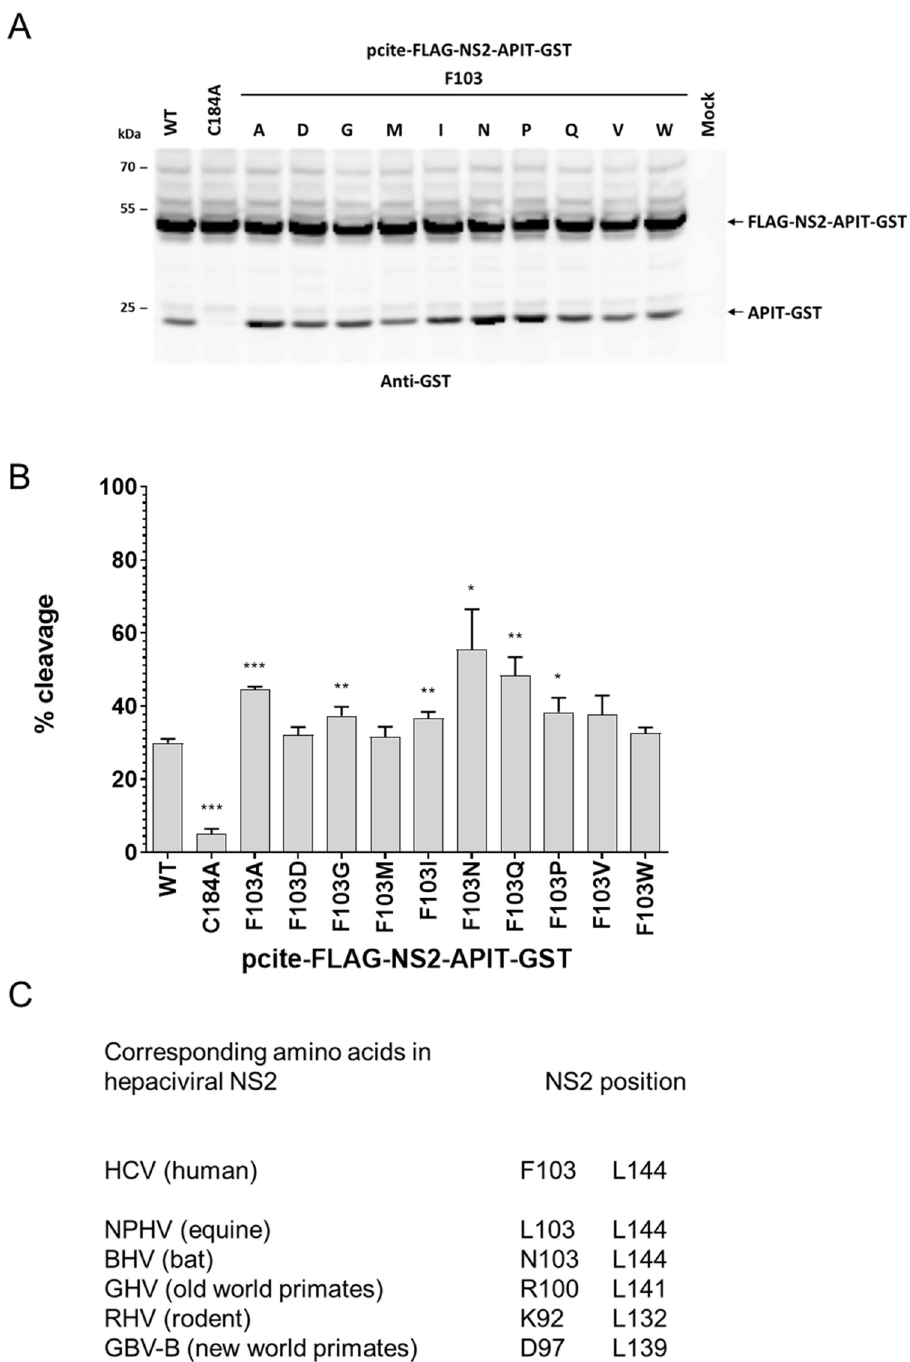
Fig 4. F103 permutation analysis revealed a broad spectrum of amino acids is allowing intrinsic NS2 protease cleavage. (A) Analysis of the intrinsic NS2 pro activity in the MVA/T7 pol expression system in Huh7-T7 cells. NS2-mediated cleavage of FLAG-NS2-APIT-GST was analyzed by Western blotting using GST-specific antibodies. (B) NS2 pro cleavage efficiencies. Signals of uncleaved FLAG-NS2-APIT-GST and the cleavage product APIT-GST were quantified by ImageJ from three Western blots to calculate the percentage of NS2-APIT-GST cleavage. Mean and standard deviations of NS2 pro cleavage efficiencies from three independent experiments are presented. Molecular mass standards are shown on the left. Positions of the uncleaved precursors FLAG-NS2-APIT-GST and the cleavage product APIT-GST are indicated on the right. WT: wild-type; mock: transfection control without plasmid DNA. (C) Conservation of HCV F103- and L144-corresponding NS2 residues in indicated mammalian hepacivirus